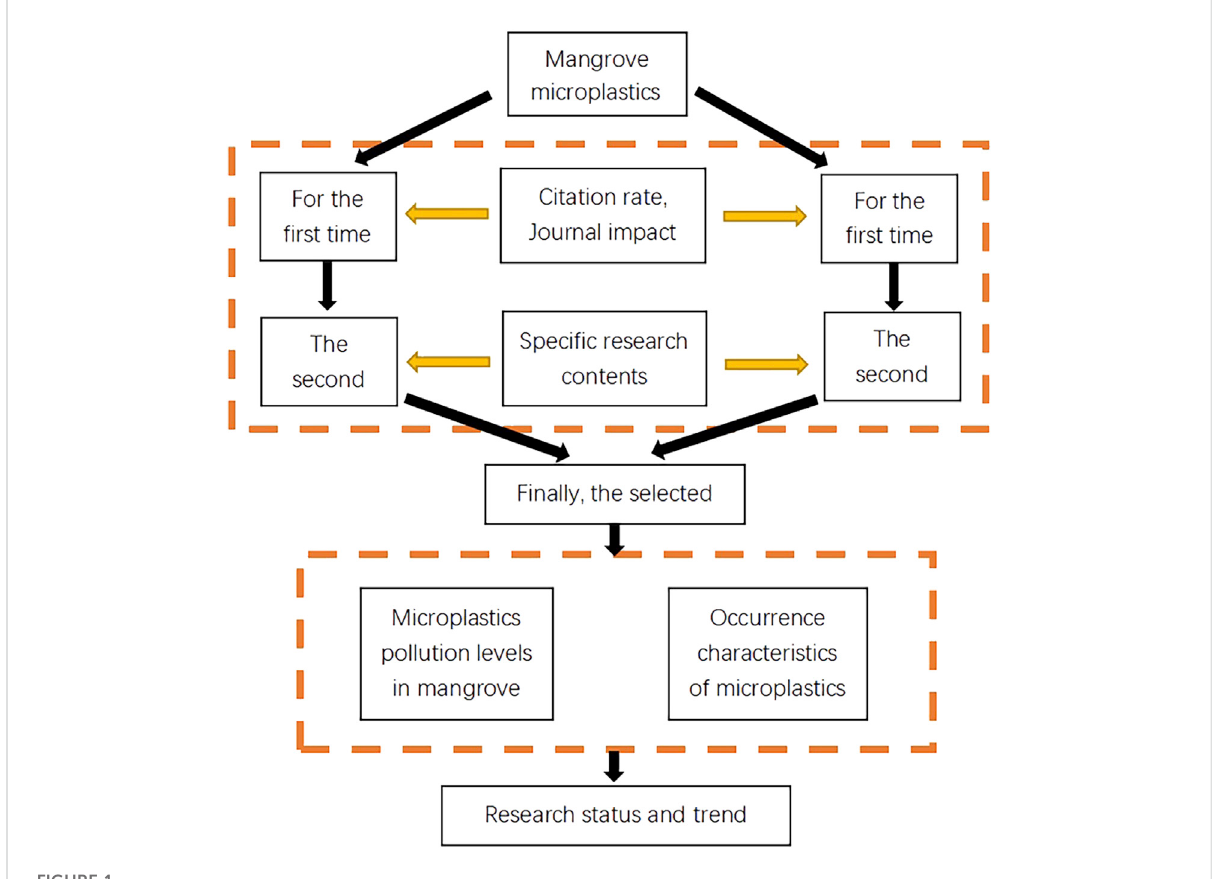
FIGURE 1 Flowchart of analysis by systematic literature review